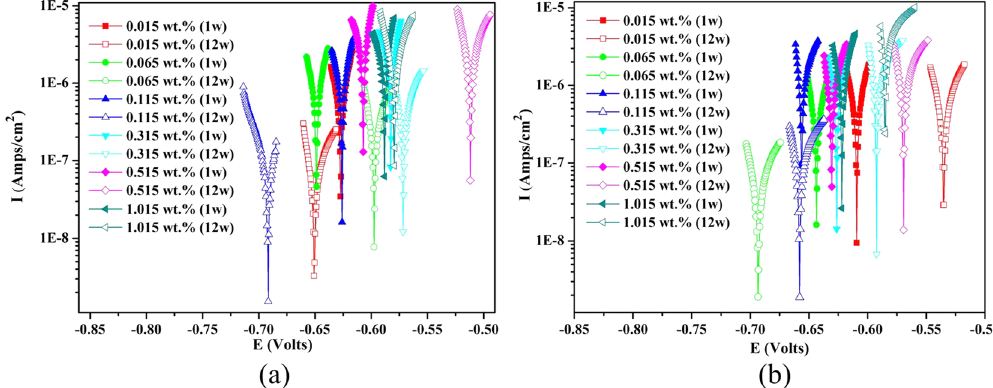
Figure 8. Polarization curves i.e. potential-log (current) of ductile iron ( a ) and carbon steel ( b ) in soils with different levels of chloride after 1 week (solid) and 12 weeks (hollow) of exposure.